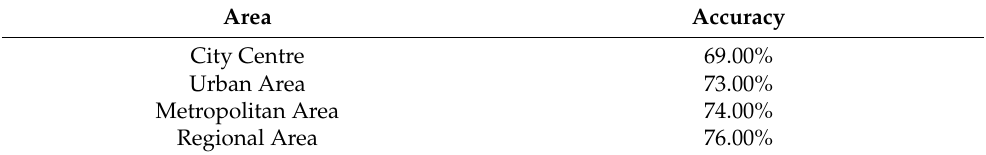
Table 3. Comparison of the matching accuracy with regards to the level of spatial